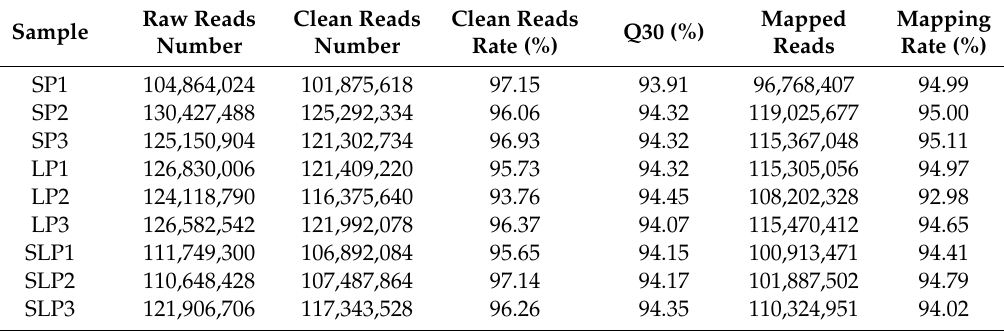
Table 1. Summary of raw reads after quality control and mapping to the reference genome.